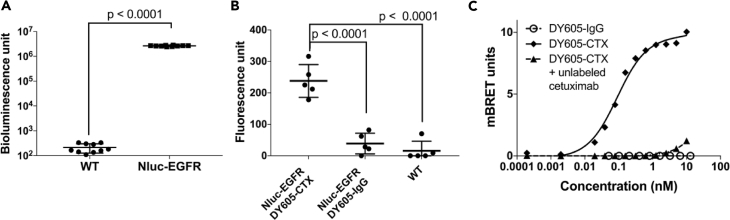
Generation and Characterization of Stable NanoLuc-EGFR HEK293 Cells(A) Under identical conditions, the BRET donor (NanoLuc) bioluminescent signal of NanoLuc-EGFR HEK293-stable cells was ∼10,000 fold higher compared with wild-type HEK293 cells (two tailed, unpaired Students t test, p < 0.0001).(B) EGFR fusion expression levels were probed using DY605-cetuximab and found to be ∼5-fold higher in the NanoLuc-EGFR stable cells compared with wild-type HEK293 cells (two tailed, unpaired Students t test, p < 0.0001). For both panels (A) and (B), representative results are shown. Each data point represents one technical replicate. Error bars represent ±SD values. At least three independent biologic replicates were performed per experiment.(C) BRET activity from the NanoLuc-EGFR/DY605-cetuximab system is concentration dependent (KD = 0.1 ± 0.01 nM, Bmax = 9.9 ± 0.24 mBRET units). No BRET was observed for the DY605-IgG control indicating negligible non-specific binding. Moreover, DY605-cetuximab binding to NanoLuc-EGFR is highly specific because no BRET signal was detected in the group containing DY605-cetuximab + unlabeled cetuximab (1 mM) due to the competition for the same EGFR domain. Each data point represents the mean value of three technical replicates. Data are presented as mean ± SD. The experimental results are representative of at least three biologic replicates. For panels (B and C), the DY605-cetuximab has DAR = 3.8.